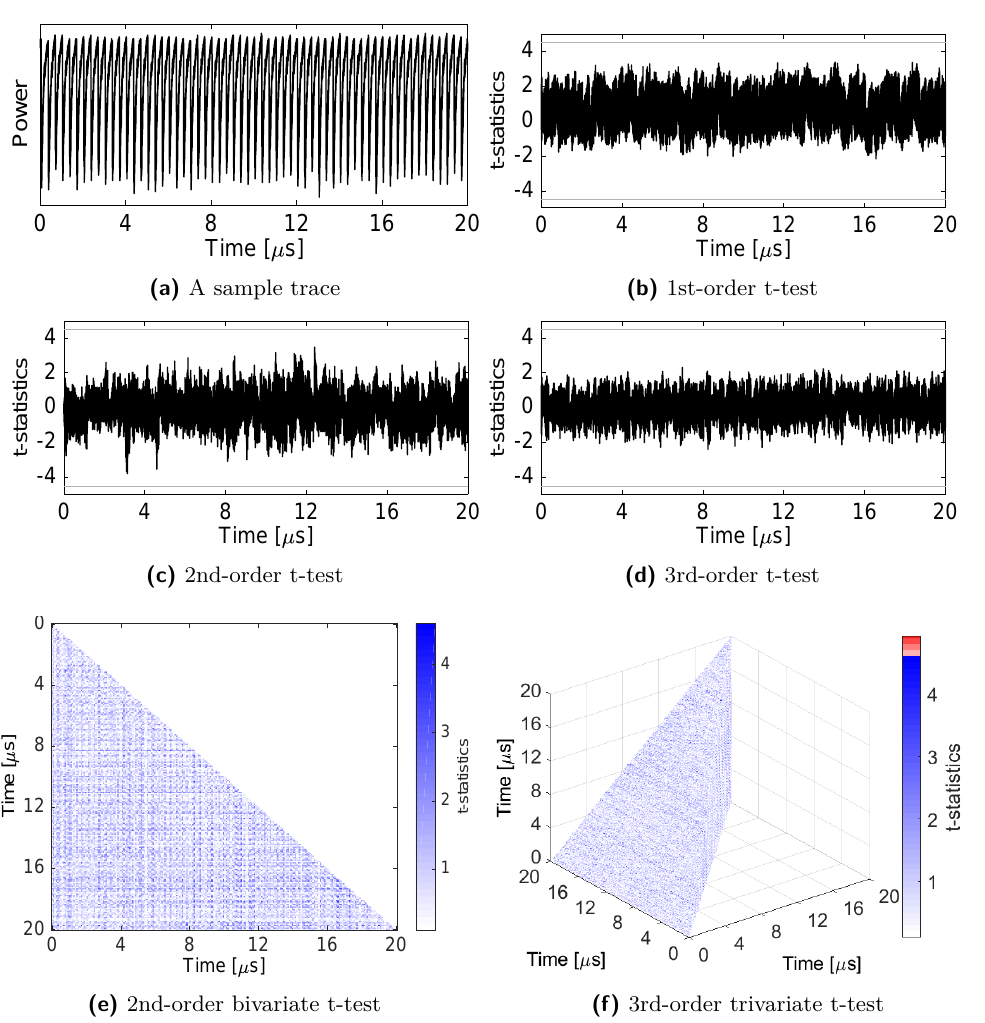
Figure 9: Experimental analysis of our masked Skinny using 100 million